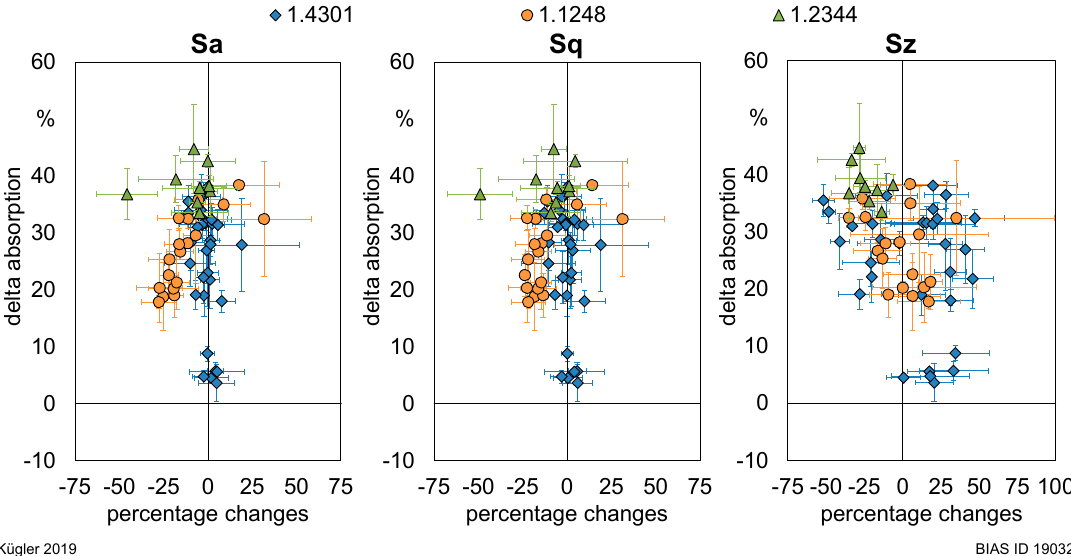
Figure 9. Influences of the roughness values Sa , Sq , and Sz on absorptivity changes of di ff erent steel sheets.